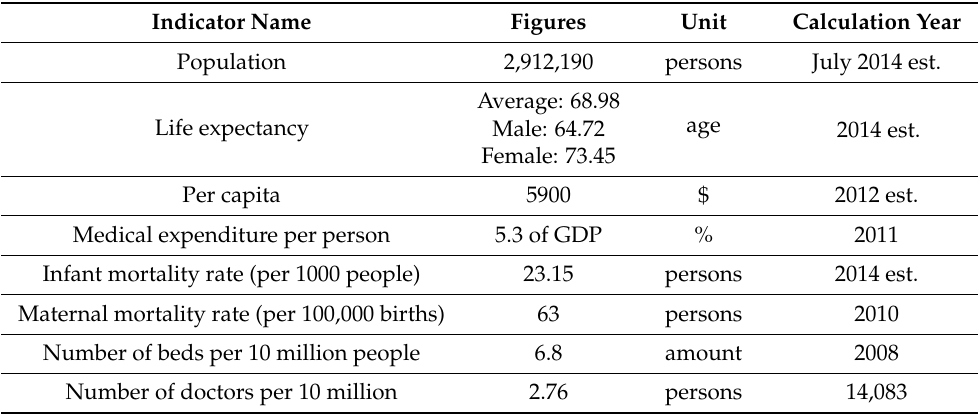
Table 1. Major health indicators.